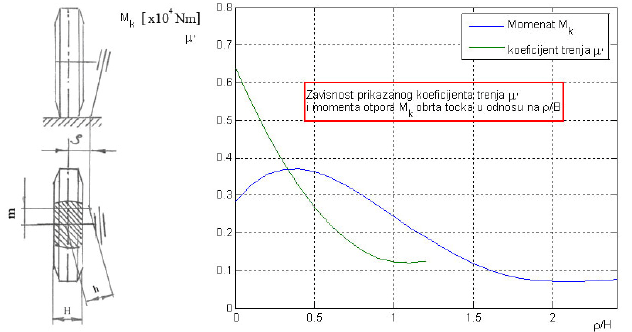
Figure 1 – Dependence of the given friction coefficient ' μ and the moment of resistance M of the wheel rotation in relation to H/ ρ ( Demi ć , et al, 1994) k I i A teško odre đ uju pa i ovaj izraz nema nekog prakti č nog Obi č no se 0 0 ρ= h